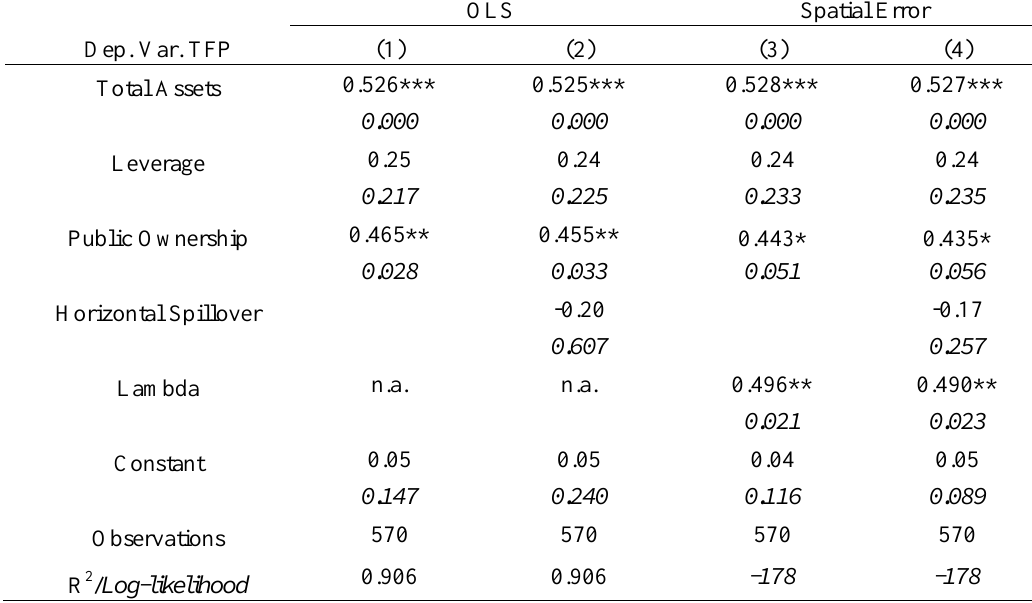
Table 2: Urban Domestic Productivity Determinants: The Aggregate Electricity Sector OLS Spatial